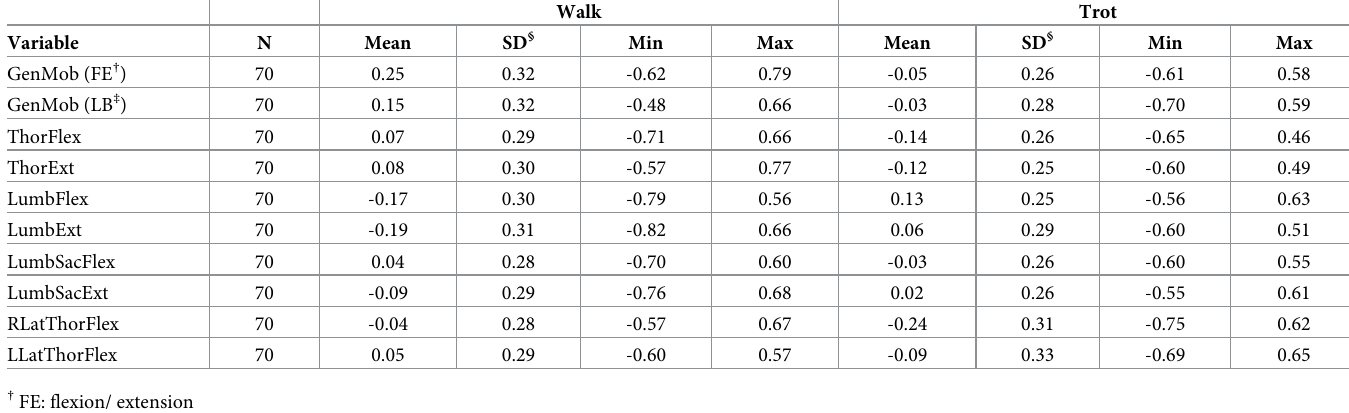
Table 3. Means (Mean), standard deviations (SD), minima (Min), maxima (Max) correlations between visual observations and objective measurements in walk and trot (abbreviations see Table